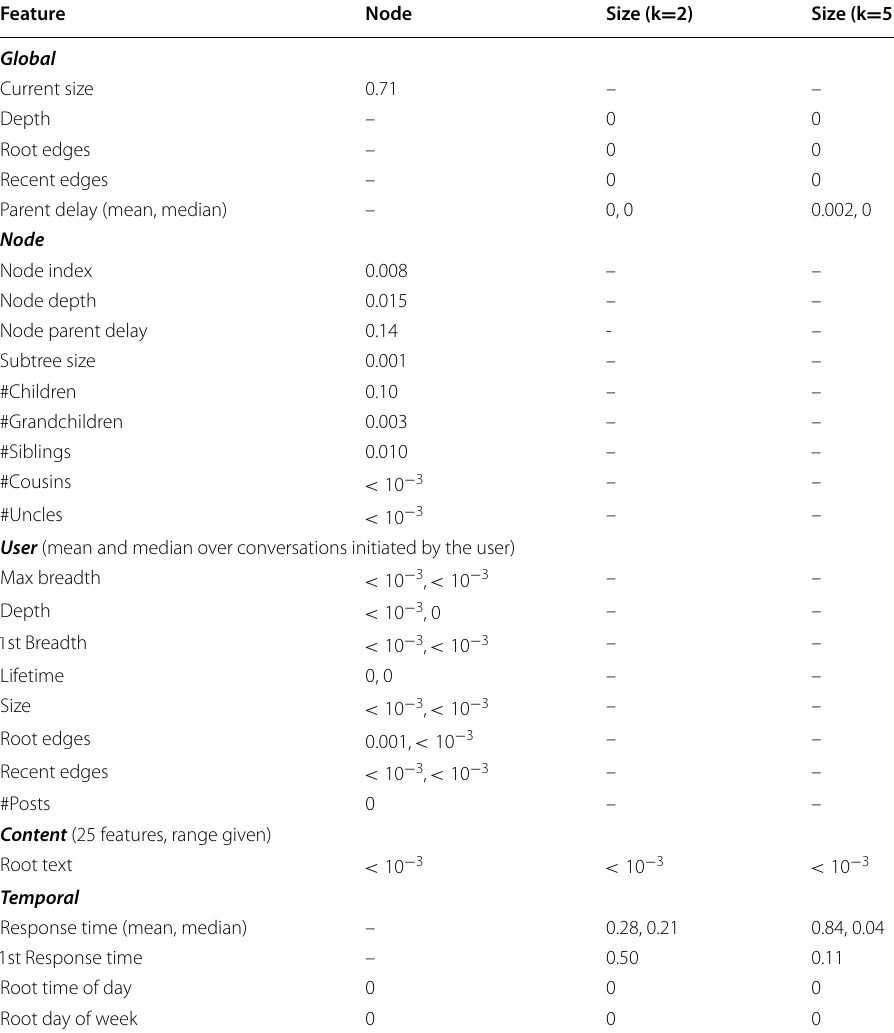
Table 5 Feature importance in the node placement classifier and the size prediction regression model at k 2 and k 5, both for the Reddit Crypto dataset. Reddit CVE = = feature importance is